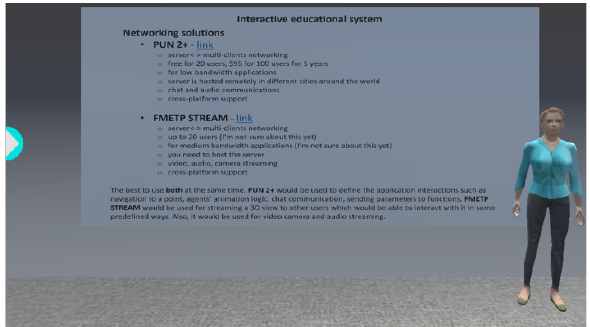
Figure 7: A person giving a